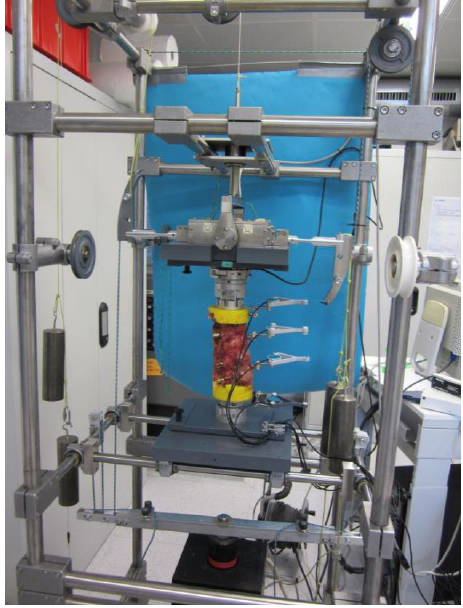
Figure 2. Spine tester (Schunk FT Delta SI 660-60, Lau ff en / Neckar, Germany) with six degrees of freedom; three in translation (green) and three in rotation (orange). Specimen embedded in